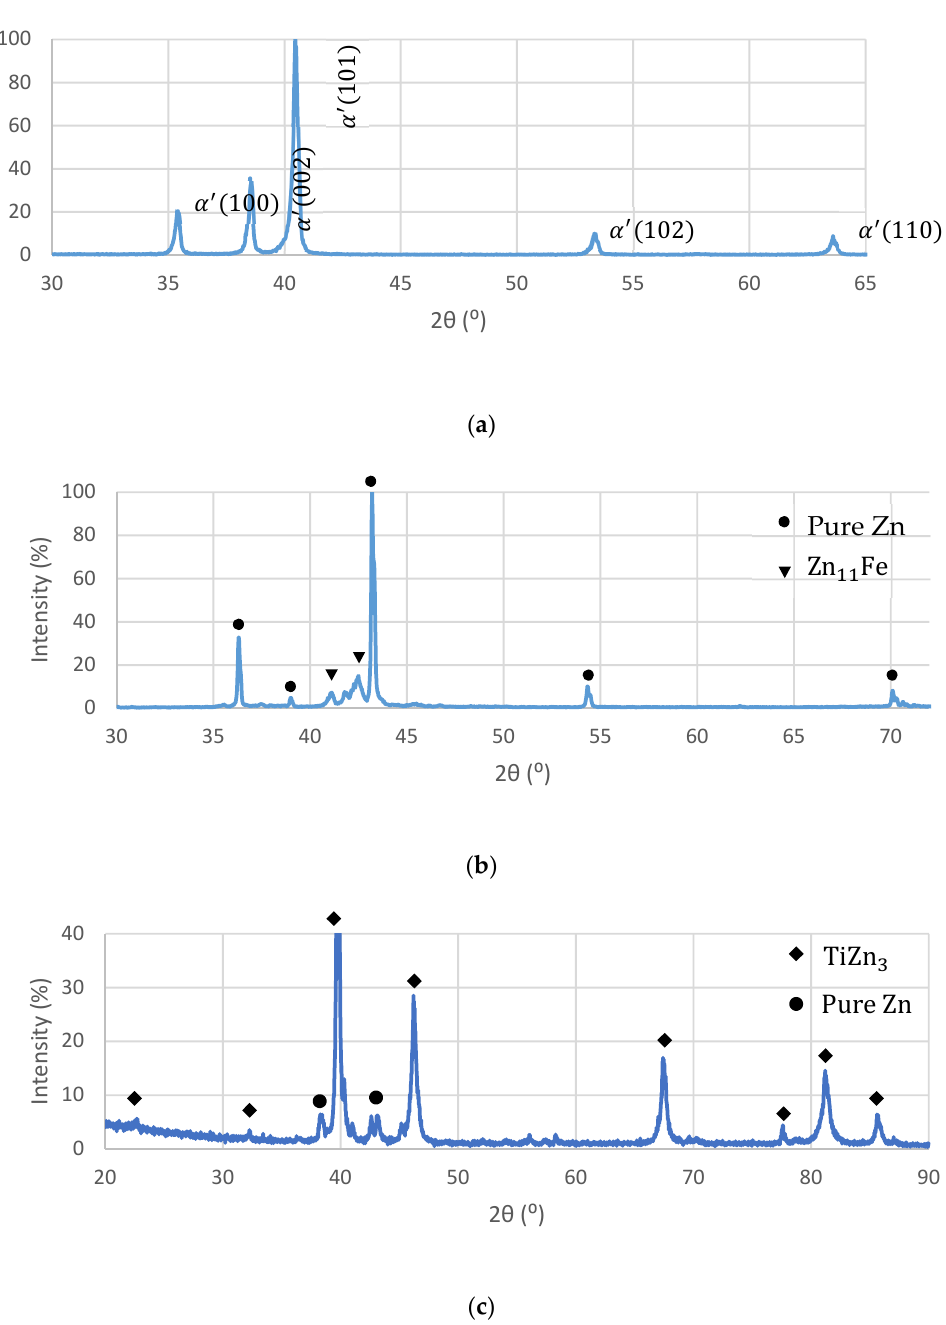
Figure 5. XRD analysis of ( a ) Ti–6Al–4V lattice, ( b ) Zn–2%Fe alloy, and ( c ) mixed powder of OI–TiZn system without the intact Ti-base lattice rods.